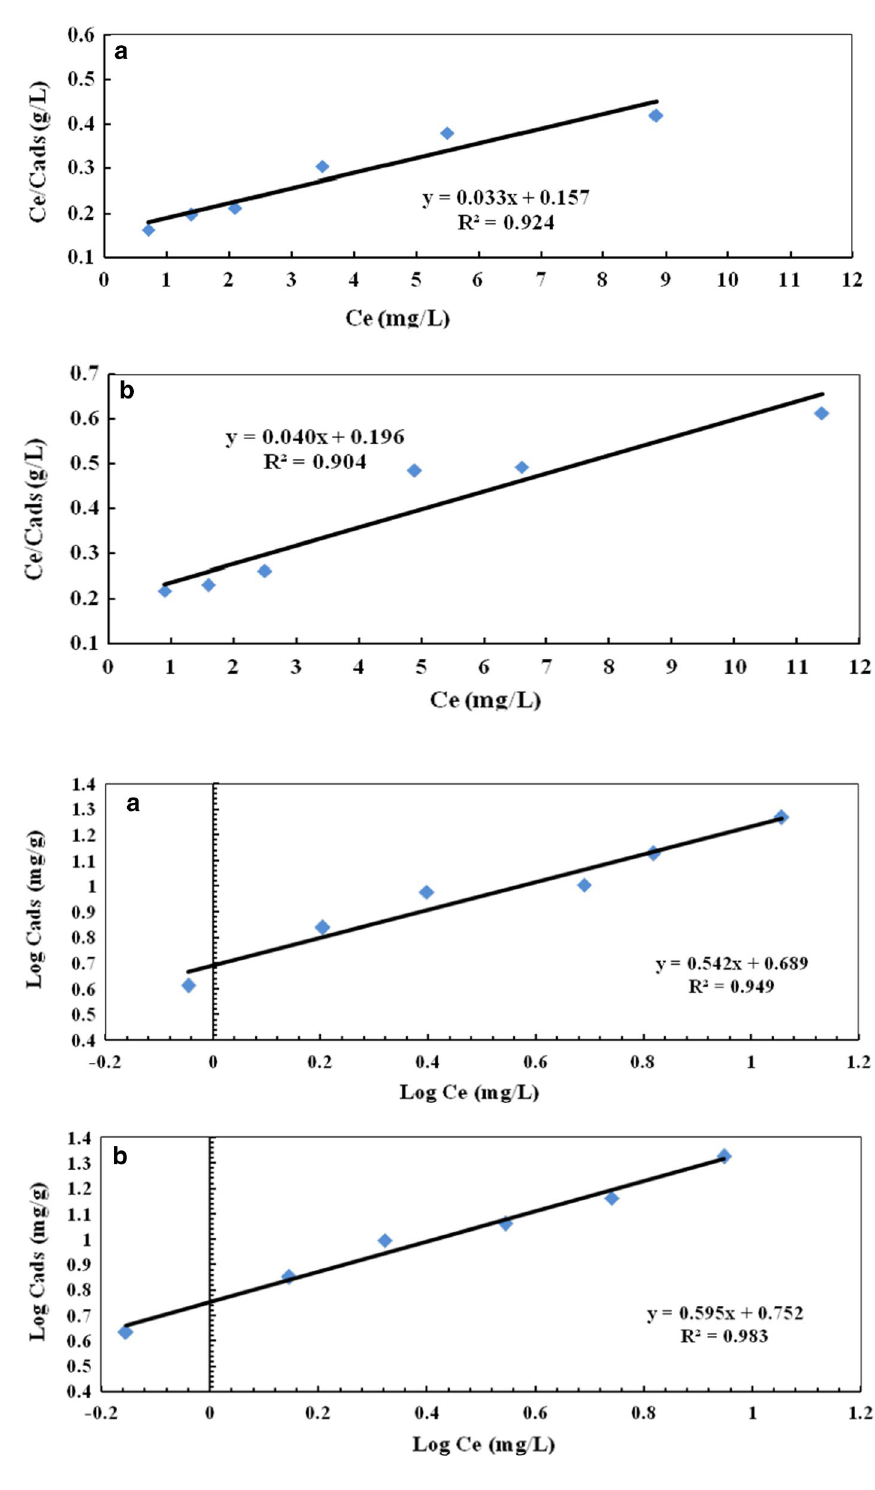
Fig. 9 a , b Langmuir model for chromium ions removal using